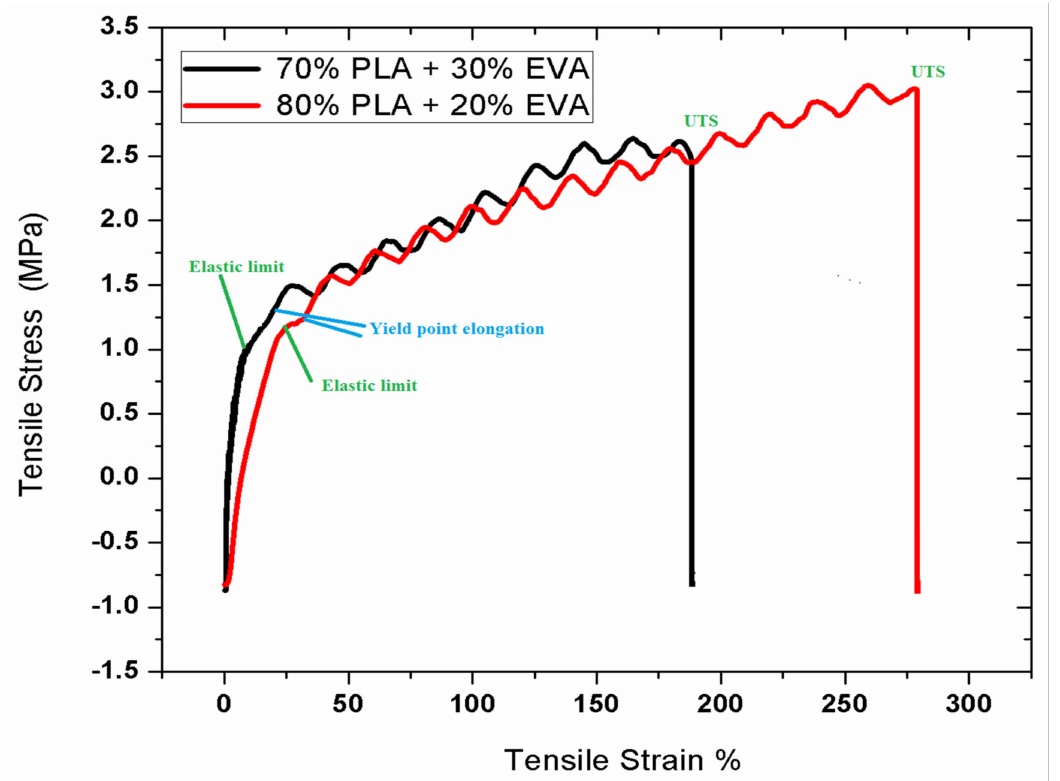
Figure 5. Stress vs. Strain graph for sample F-1 (80% PLA and 20% EVA) and F-2 (70% PLA and